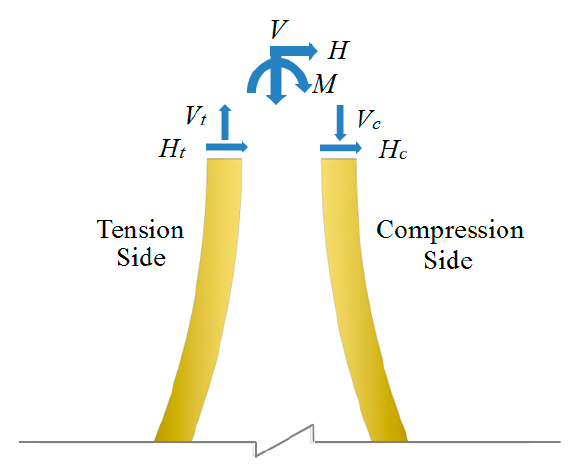
Figure 3. Schematic diagram of the load transfer.